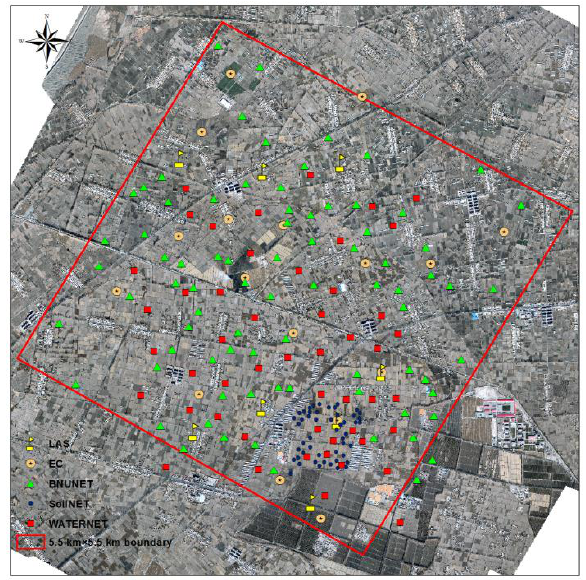
Figure. 6 The setup of the WSN deployed in the Yingke and Daman irrigation districts, the middle stream of the HRB Besides, an observing matrix composed of EC system and large aperture scintillometer (LAS) has also been established in the middle stream of the HRB. This observing matrix provides multi-scale data sets of meteorological elements and land surface parameters for the estimation of regional ET over heterogeneous surfaces, to identify scale effects and to deliver ground truths that correspond to the development of the remote sensing models and scale transformation approaches in association with validation purposes (Liu et al., 2013; Xu et al.,